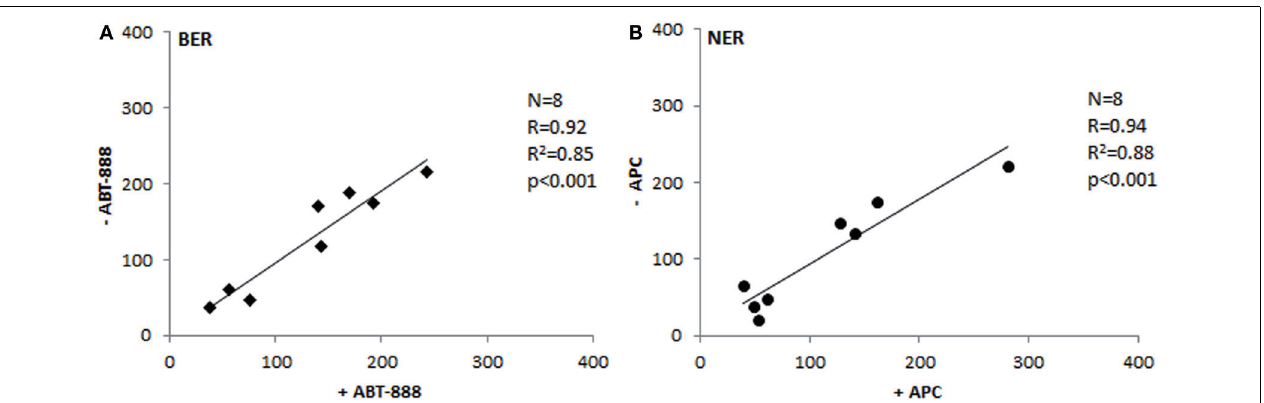
FIGURE 5 | Testing the inhibition of post-incision phase. Comparison of BER (A) and NER (B) activities between extracts treated with inhibitors of polymerization and the same extracts not suppressed for the polymerization